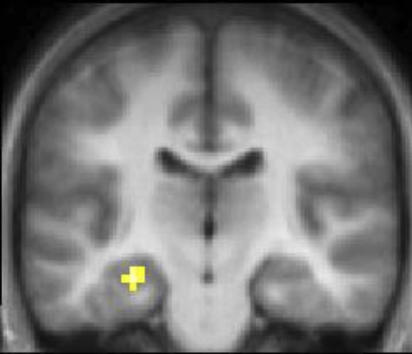
Hippocampal activity signals the presence of a mismatch between what is expected to happen and what actually does.